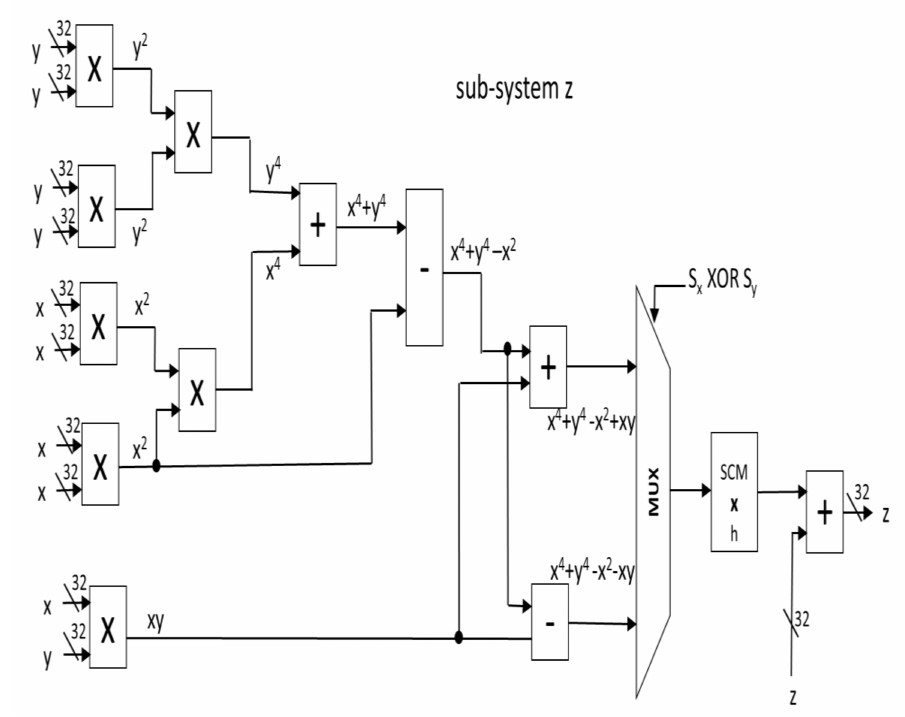
Figure 19. Realization of the sub-system Z on